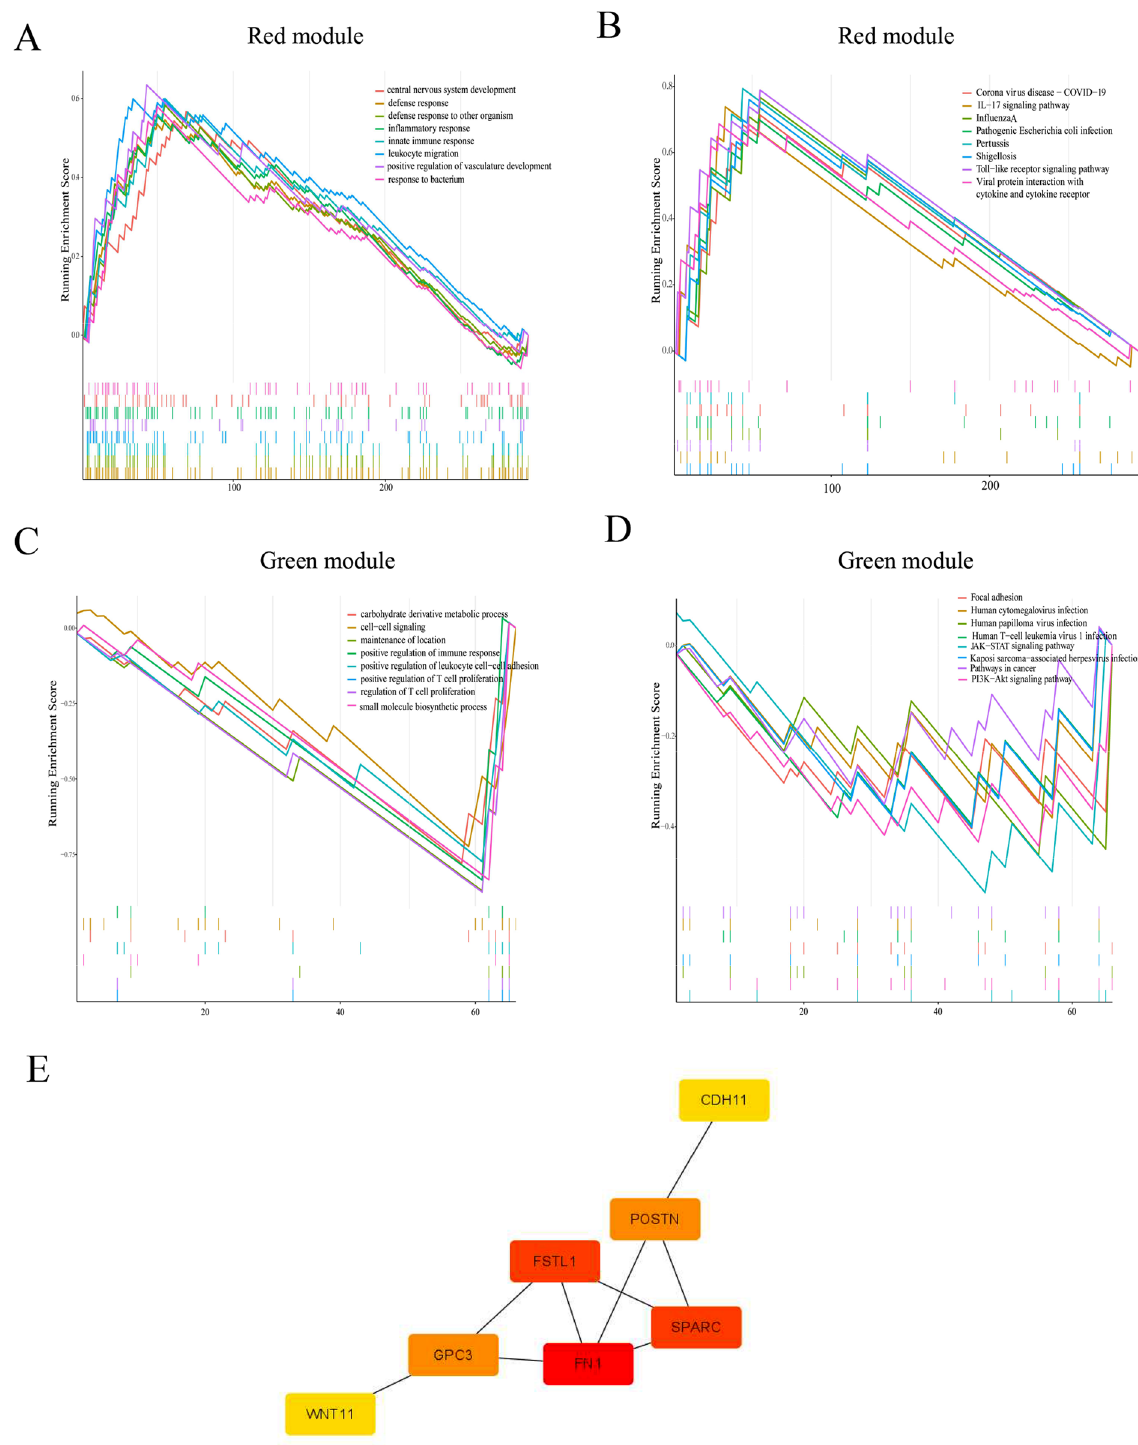
Figure 5. Gene set expression analysis (GSEA) of red and green modules and protein–protein interaction (PPI) network construction. ( A ) GSEA results of the red module biological processes (BP). ( B ) GSEA analysis of red module (Kyoto Encyclopedia of Genes and Genomes [KEGG]). ( C ) GSEA analysis of the green module (BP). ( D ) GSEA result of the green module (KEGG). ( E ) PPI network construction of EMT hub genes via cytoscape; the darker the color, the higher the connectivity. A – D were visualized by R software 4.0.3 and E were visualized via